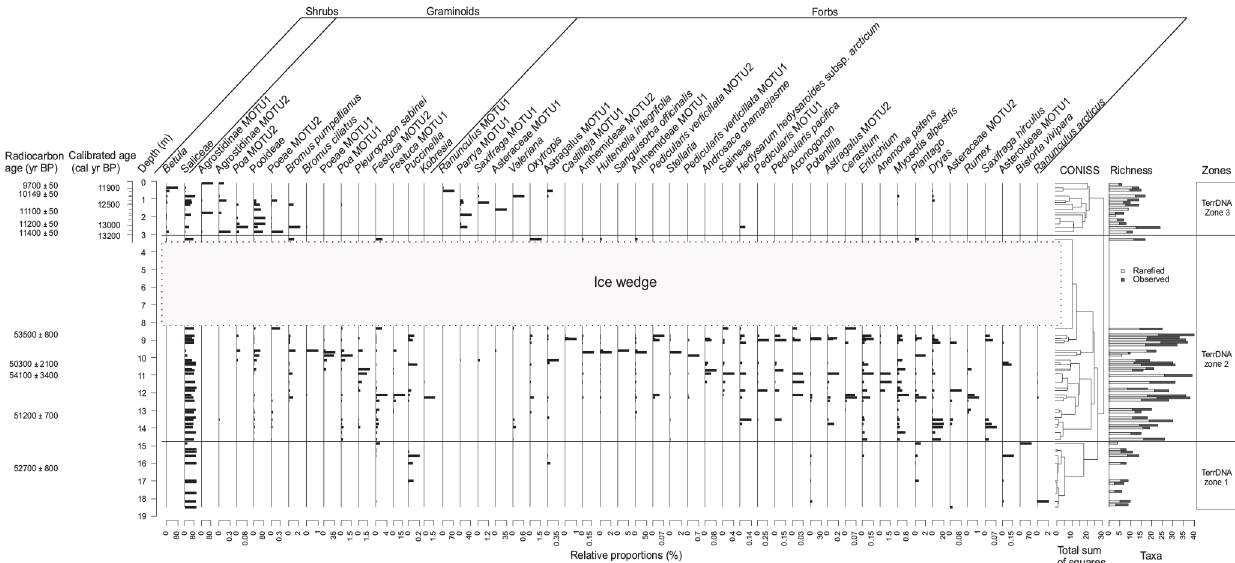
Figure 2. Stratigram of terrestrial sedaDNA (subset for statistical analyses) with relative proportions in percent of the taxa in each sample as horizontal bars, CONISS dendrogram, observed (dark grey) and rarefied (light grey) taxonomic richness. Uncalibrated radiocarbon ages are given with standard error in years before present (yrBP) and calibrated ages from the age–depth model in calendar years before present (calyrBP). The grey area indicates the ice wedge where no samples were taken. Horizontal lines indicate borders between zones. Scaling is taxon-specific for better visibility of low